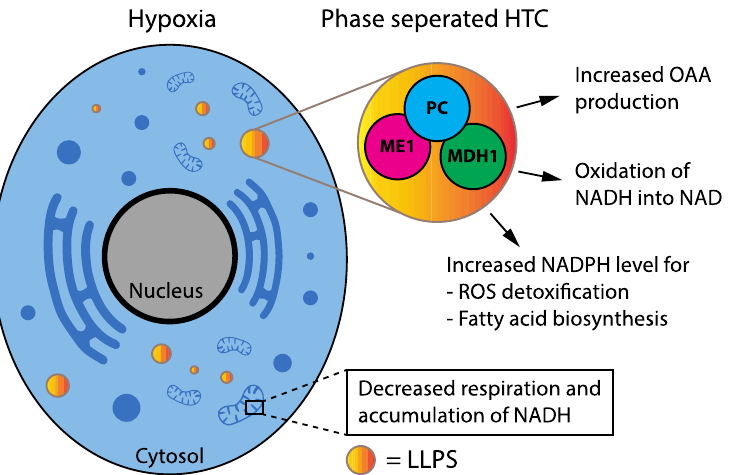
Figure 4. Hydride transfer complex (HTC), a phase-separated oncometabolon. Under hypoxia ME1, PC and MDH1 form a complex in LLPS leading to OAA production, oxidation of NADH into NAD and increased NADPH level.